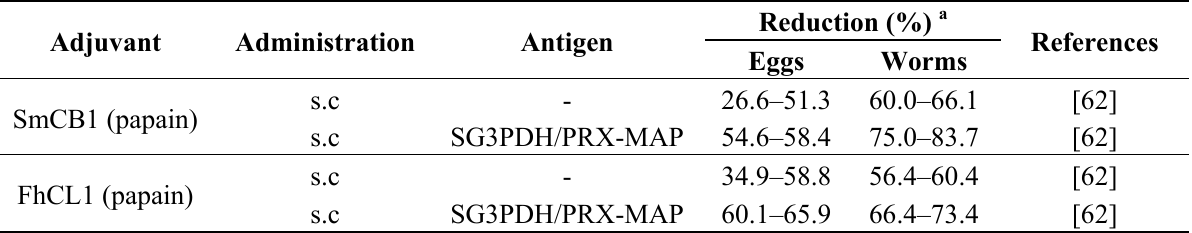
Table 8. Other-adjuvanted Schistosoma vaccine candidates as a function of the